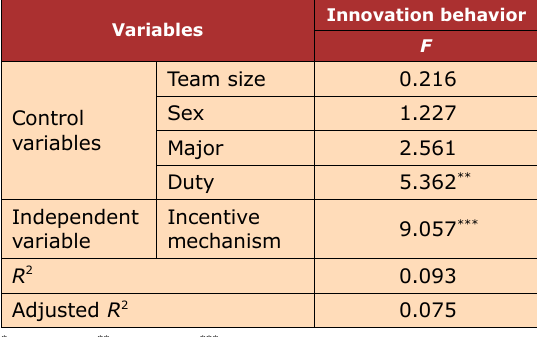
Table 1. Results of